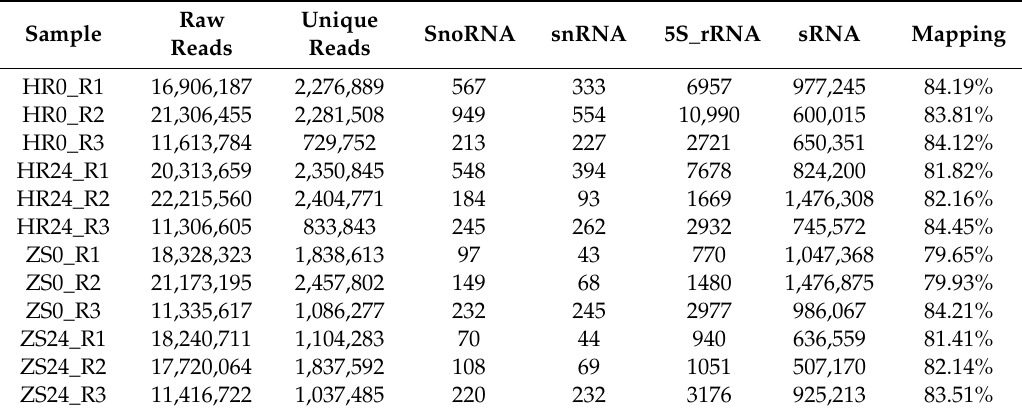
Table 1. sRNA-Seq classification of twelve